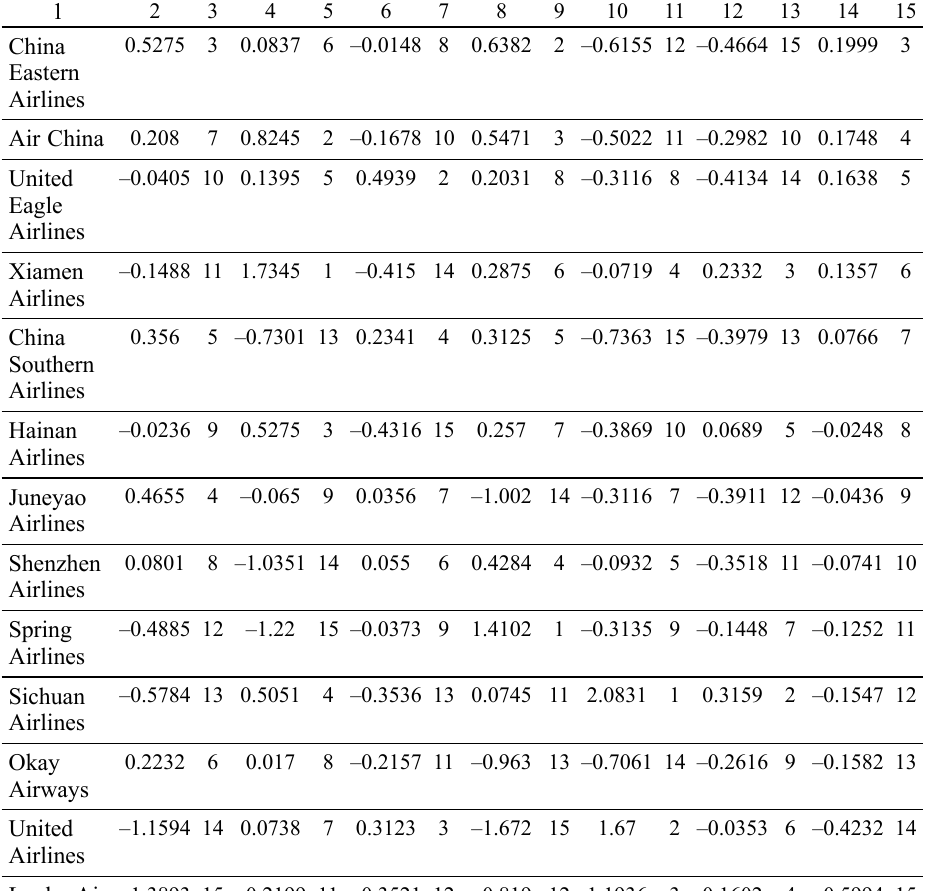
Table 12. Score & Ranking of Airline Competitiveness in 2009 based on AHP